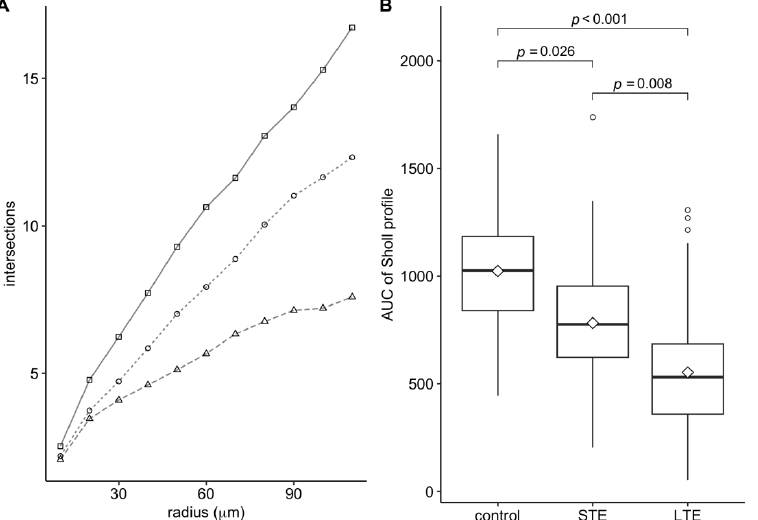
Figure 4. Effect of blue light exposure on dendritic arborization of intrinsically photosensitive retinal ganglion cells (ipRGCs). The rats were exposed to 12 h white light (150 lx) and 12 h darkness for 10 d (control, 9 rats), cycles of 12 h blue light (150 lx) and 12 h darkness for 10 d (long-term exposure, LTE; 9 rats), and constant blue light (150 lx) for 2 d (short-term exposure, STE; 9 rats). ( A ) Sholl profiles: squares, circles, and triangles (control, STE, and LTE groups, respectively) show mean number of melanopsin-positive dendrites intersecting each radius around the ipRGC somas. ( B ) Area under the curve (AUC) of each Sholl profile shown in Figure 4A. The boxes show the central 50% of the data, diamonds show the mean AUC, thick horizontal lines show the median, vertical lines outside the box extend to the furthest non-outlying data points, and circles show outliers. p -values were calculated using a mixed model followed by Tukey’s method for pairwise comparisons.